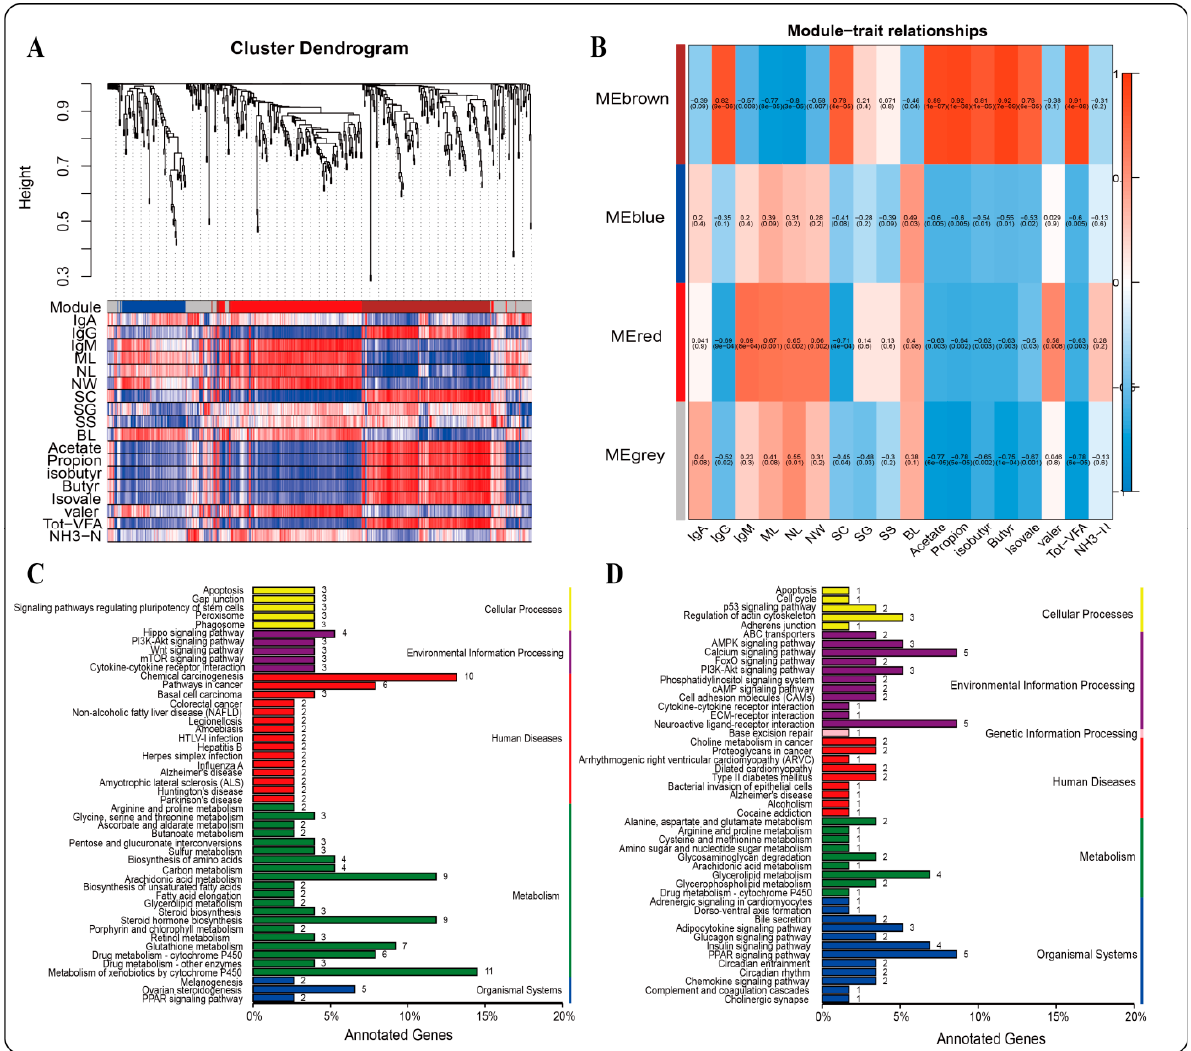
Figure 7. WGCNA analysis. ( A ): Gene-phenotype cluster; ( B ): WGCNA module diagram; ( C ): KEGG enrichment diagram (MEbrown); ( D ): KEGG enrichment diagram (MEred).